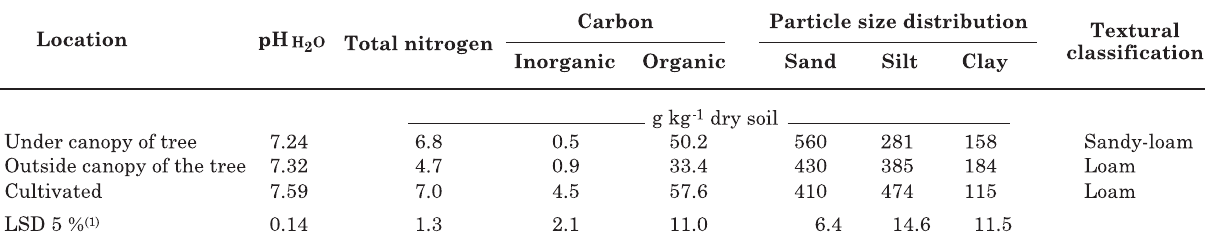
Table 1. Properties of surface soil samples from under and outside the canopy of Acacia angustissima and from soil under